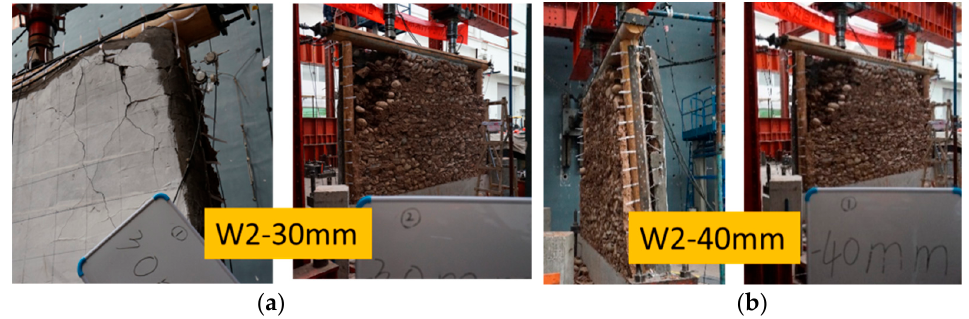
Figure 13. Displacement loading for W2: ( a ) 30 mm and ( b ) 40 mm.